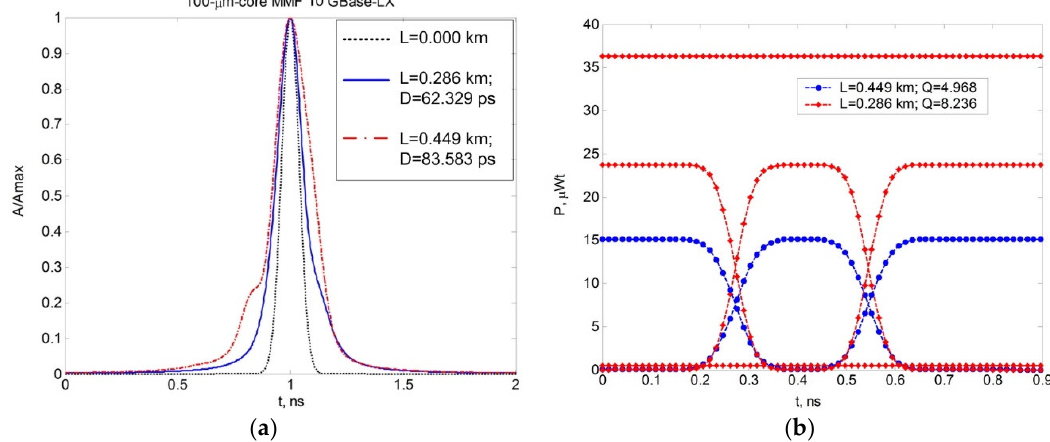
Figure 12. 10GBase-LX data transmission over a 100 μm core MMF without special launching conditions: ( a ) pulse response; ( b ) eye diagram envelope.